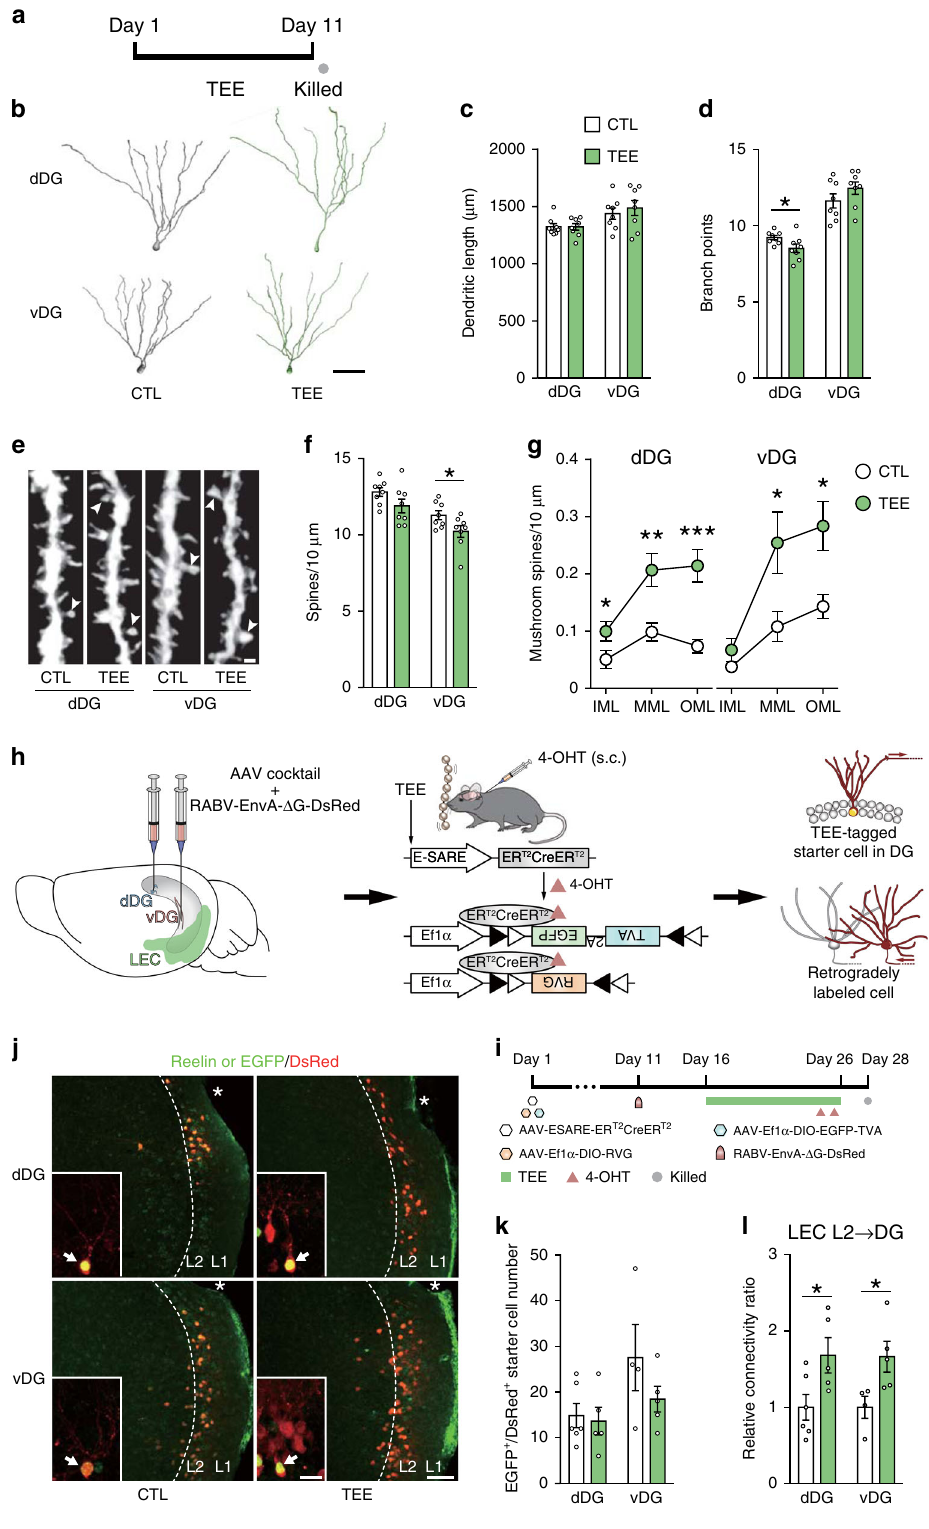
S1-innervated LEC neurons modulate the behavioral effects of tactile enrichment . To evaluate the in fl uence of S1 input on the activation of LEC and DG neurons, the hM3Dq-expressing AAV was injected to the S1 of Scnn1a-Cre mice that expressed Cre in S1 layer 4 excitatory neurons 36 (Fig. 7a). Both acute and chronic